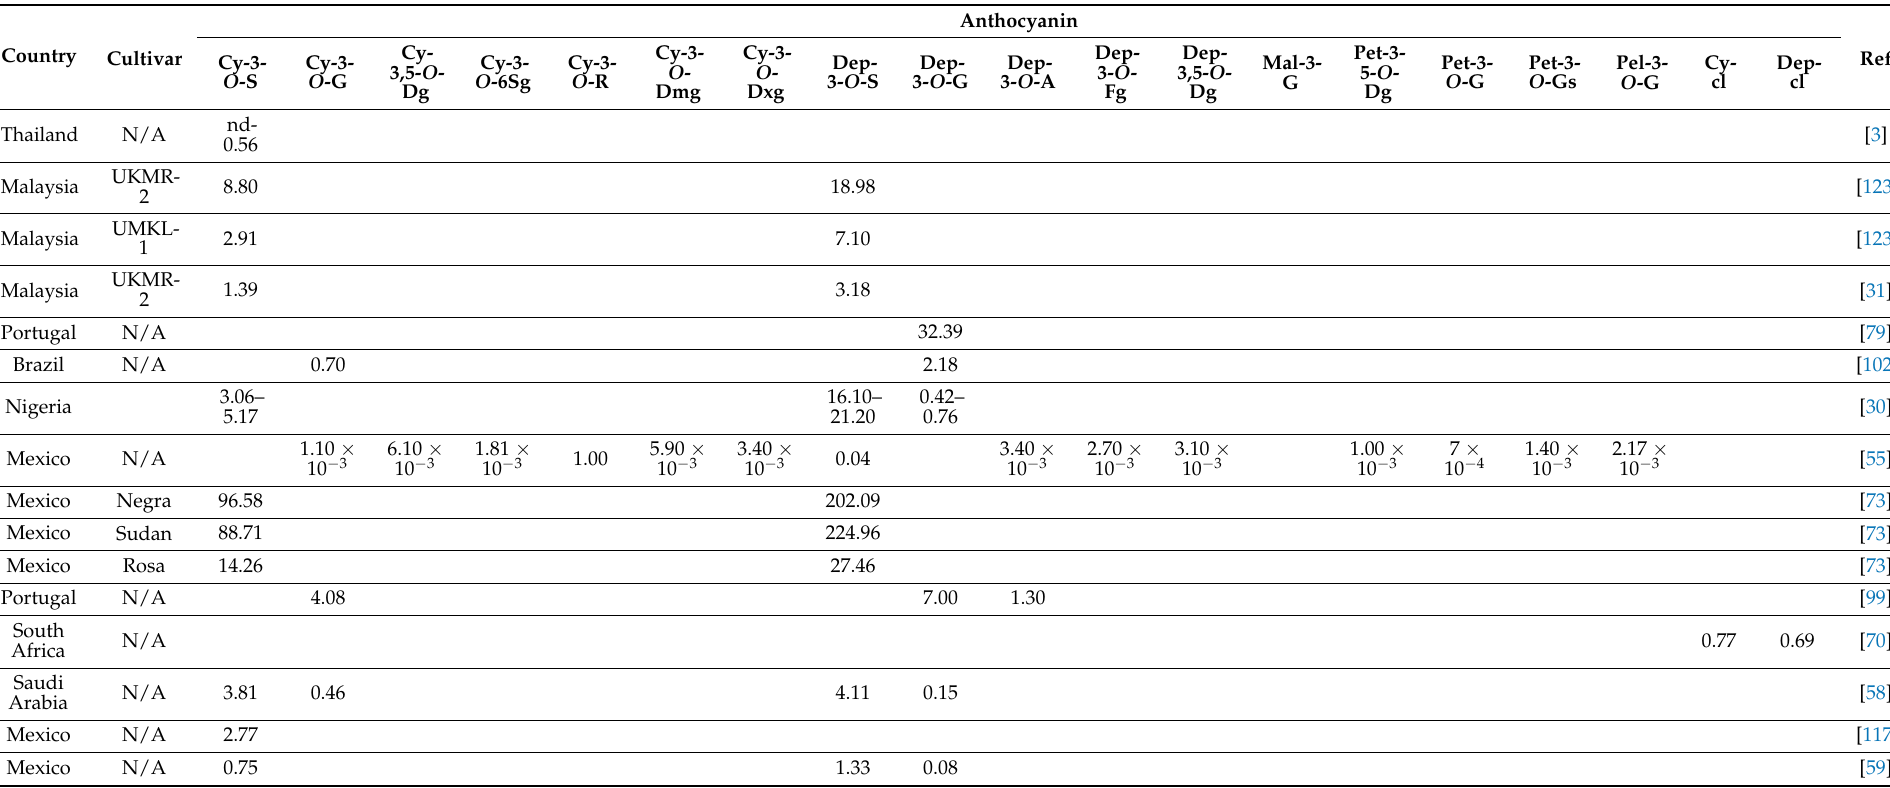
Table 6. Anthocyanin compounds from roselle calyx (mg/g). Abbreviations: N/A: not available, nd: not detected, Cy-3- O -S: cyanidin-3- O -sambubioside, Cy-3- O -G: cyanidin-3- O -glucoside, Cy-3,5- O -Dg: cyanidin 3,5- O -diglucoside, Cy-3- O -6Sg: cyanidin 3- O -(6”-succinyl-glucoside), Cy-3- O -R: Cyanidin 3- O -rutinoside, Cy-3- O -Dmg: cyanidin 3- O -(3”,6”- O -dimalonil-glucoside), Cy-3- O -Dxg: Cyanidin 3- O -(6”-dioxalil-glucoside), Dep-3- O -S: delphinidin-3- O -sambubioside, Dep-3- O -G: delphinidin 3-glucoside, Dep-3- O -A: Delphinidin-3- O -arabinoside, Dep-3- O -Fg: Delphinidin 3- O -feruloil-glucoside, Dep-3,5- O -Dg: Delphinidin 3,5- O -diglucoside, Mal-3-G: malvidin 3-glucoside, Pet-3-5- O -Dg: Petunidin 3–5,- O -diglucoside, Pet-3- O -G: Petunidin 3- O -glucoside, Pet-3- O -Gs: Petunidin 3- O -galactoside, Pel-3- O -G: Pelargonidin 3- O -glucoside, Cy-cl: Cyanidin chloride, Dep-cl: Delphinidin chloride, Mal-cl: Malvidin chloride, Peo-cl: Peonidin chloride, and Pel-cl: pelargonidin